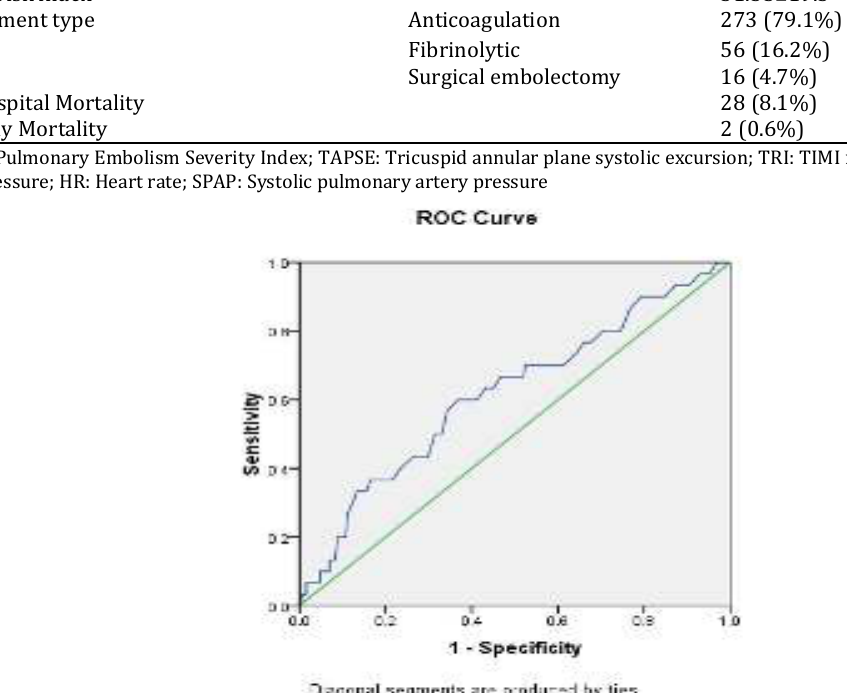
Figure 1. Receiver operating characteristic curve analysis for optimal threshold value of thrombolysis in myocardial infarction risk